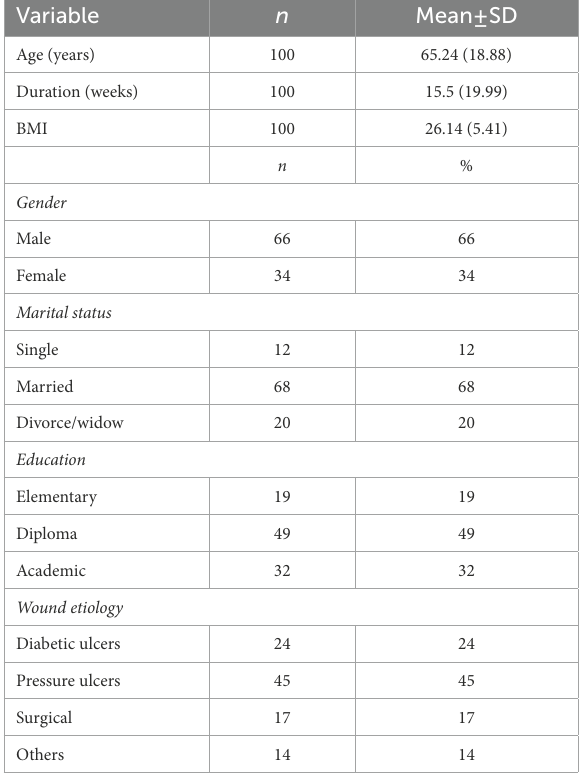
TABLE 1 Demographic and clinical characteristics of the study